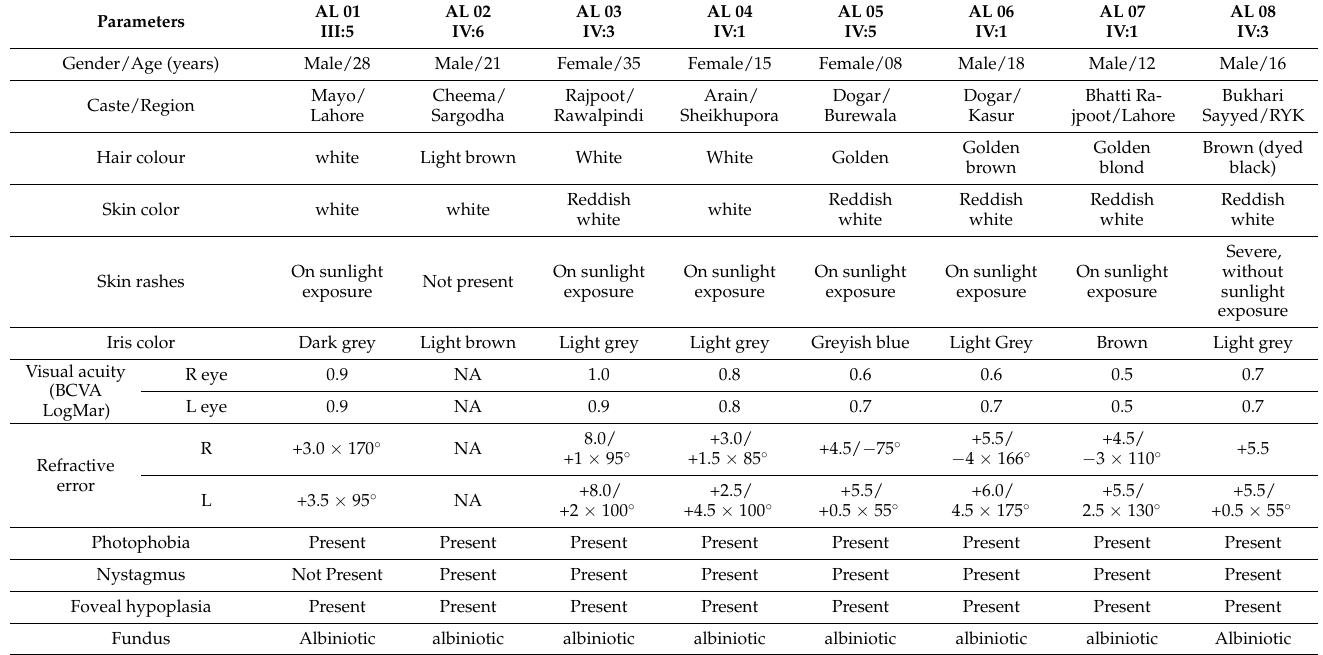
Table 1. Physical and clinical features observed in OCA